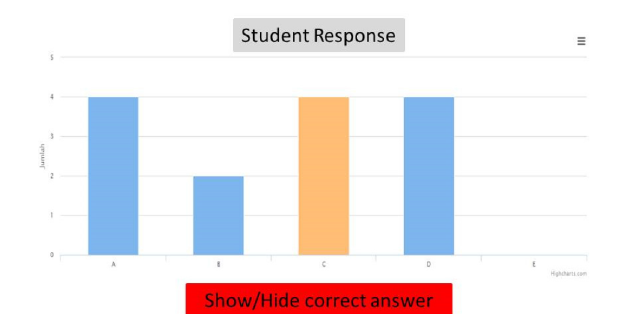
Figure 6. Example of the Graph of Student Response on Webvoting